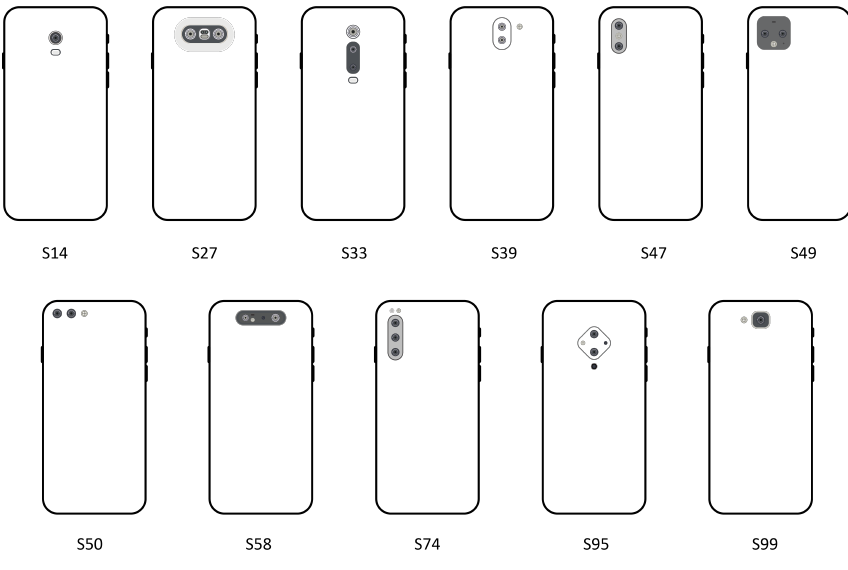
Figure 6. Eleven representative